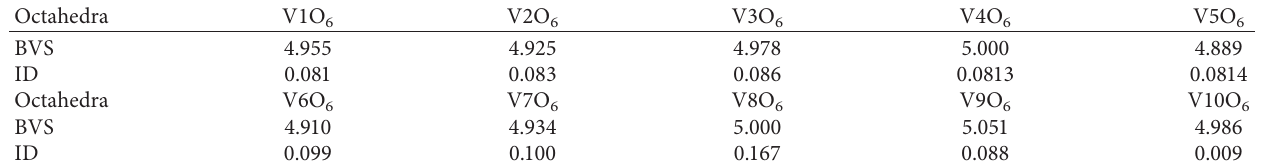
· 4.21H 7 N 3 H 20 ) 2 V 10 O 28 2 O.